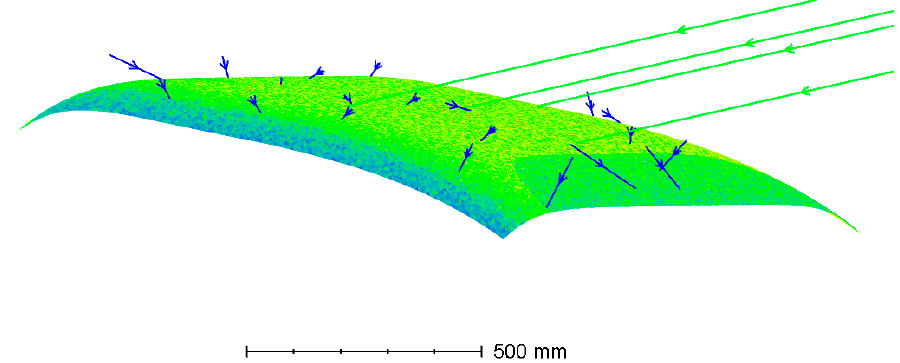
Figure 11. Solar irradiance distribution on the curved surface of the PV panel. The light-green arrow lines correspond to the direct sunlight. The blue arrow lines correspond to the scattered sunlight. The color gladiation on the curved surface indicates the non-uniformity of the irradiance on the curved surface. The darker color indicates the lower irradiance.